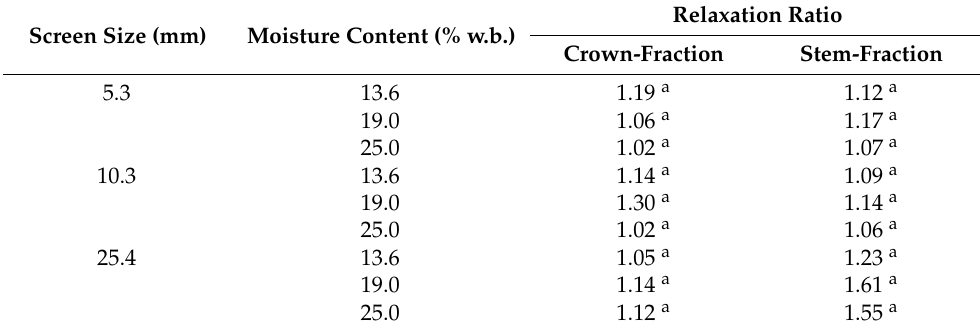
Table 6. Mean values of relaxation ratio of briquettes from poplar tree